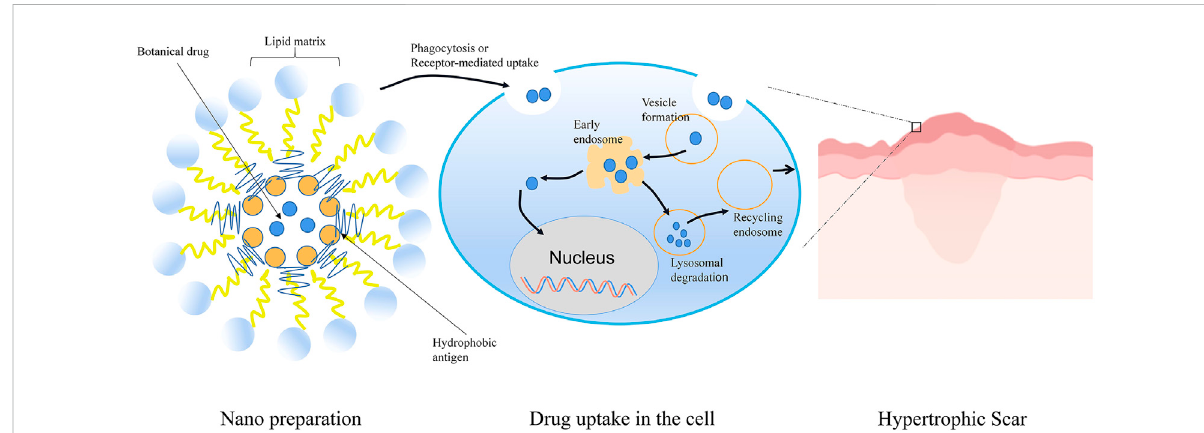
FIGURE 6 SchematicrepresentationofNanoTCMdeliverysystemtotreatHS.Botanicaldrug-loadednanoparticleswerepreparedbytheself-assembling approach. The nanoparticles were absorbed into dermal cells by phagocytosis or receptor-mediated uptake. Subsequently, the free drug was released into the cell after the process of endosome and lysosome. Nano TCM delivery system could effectively improve the solubility and permeability of active ingredients in TCM. Spiral spray paeonol nanogel showed good transdermal performance and dermal retention. Asiaticoside nanoparticles, nanoemulsion, and nanoemulsion gel effectively overcame the skin barrier and had high drug permeability to enhance the therapeutic effect of